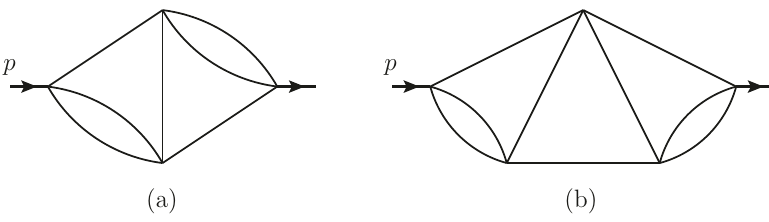
Figure 5 . Example of a four- and (cid:12)ve-loop integrals that enters the calculation of the four- and (cid:12)ve-loop amplitude respectively. The two bubbles may be integrated out, turning it into a two- and three-loop integral with two propagators raised to non-integer powers, cf. eq.